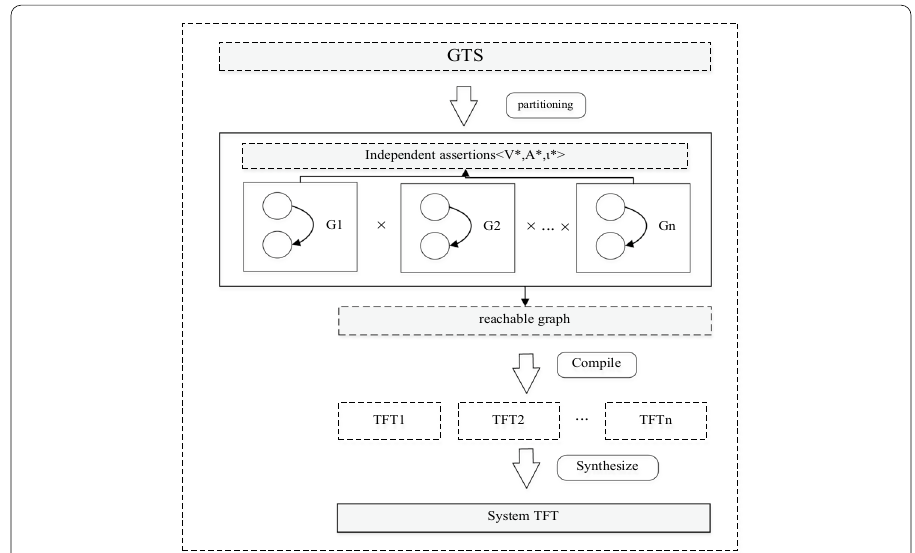
Fig. 5 Compilation of GTS into temporal fault trees or event